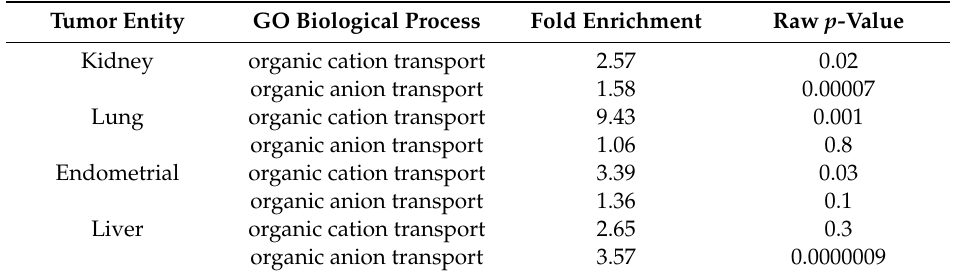
Table 1. Enriched GO terms within the list of favorable genes. A significant raw p value ( < 0.05) are highlighted in bold.